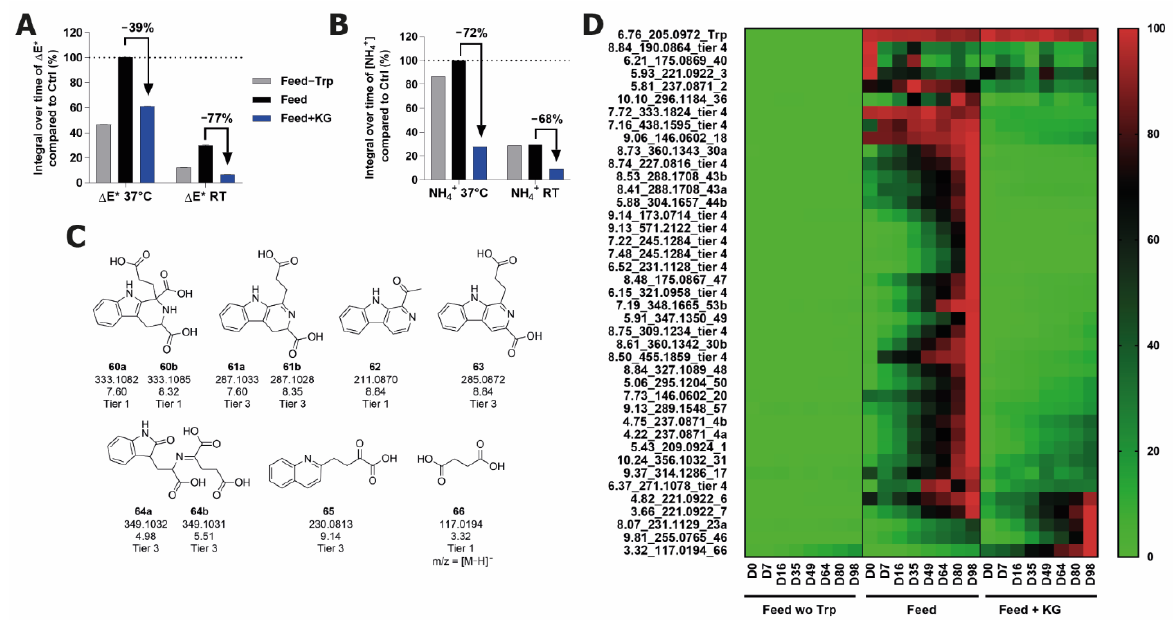
Figure 7. Changes in the feed, feed-Trp, and feed+aKG solutions during long-term storage. ( A ) Color change measured as ∆ E*. ( B ) Changes in ammonia concentration. ( C ) Structure identifications for tier 1–3 features which are newly formed upon aKG addition to feed. ( D ) Heatmap showing abundance changes of features of interest (denoted with rt_m/z_structure number for tiers 1–3, or else denoted as tier 4) at RT.